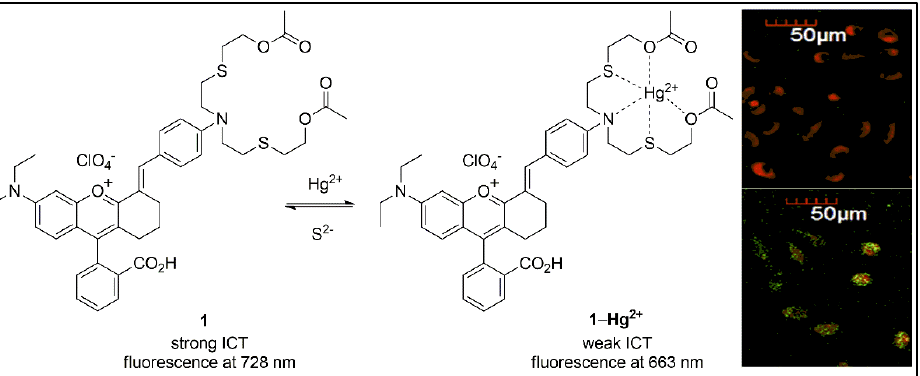
Figure 2. Fluorescence recognition mechanism and reversibility of probe 1 with Hg 2+ ion. Fluo- rescence image of L929 cells incubated with probe (5 µ M) after staining for 30 min (upper panel) and after incubated with Hg 2+ (50 µ M) for another 30 min (lower panel). Adapted with permission from [38]. Copyright (2019)